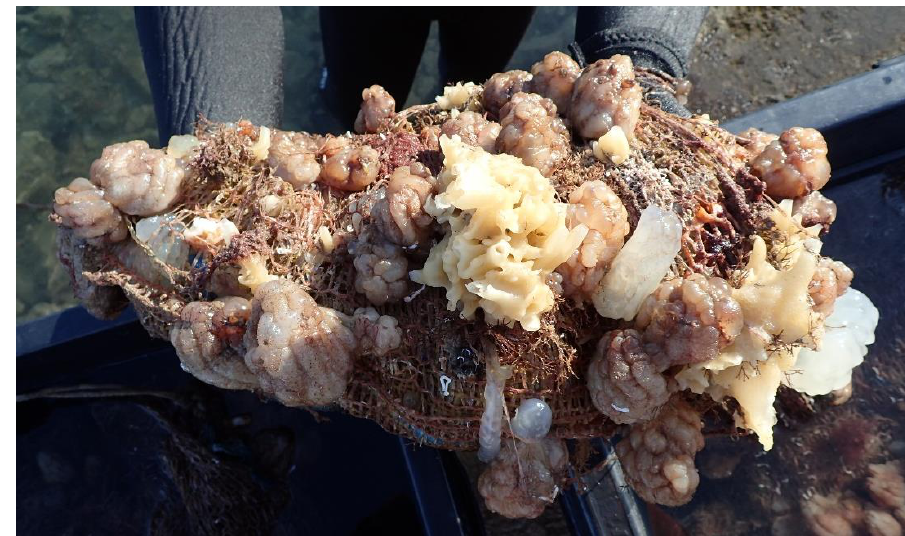
Figure 12. Another collector bag from Luka Cove on which, aside from ascidians, two big and some small individuals of the invasive sponge Paraleucilla magna can be seen.